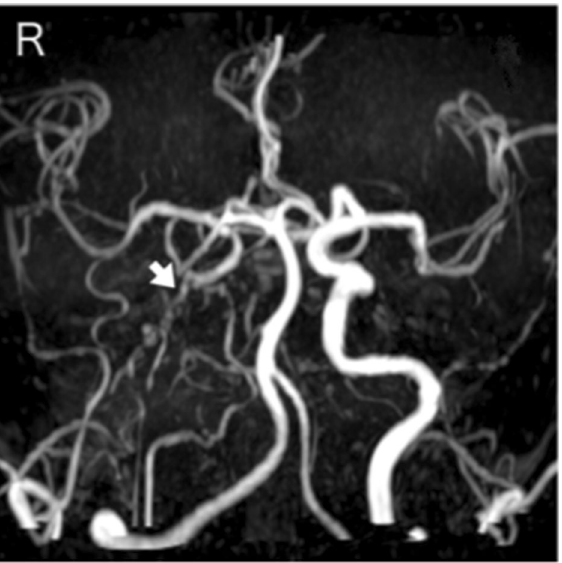
Figure 1. Anterior posterior view of magnetic resonance angiography findings in patient 1 indicating hypoplasia of the right internal carotid artery (white